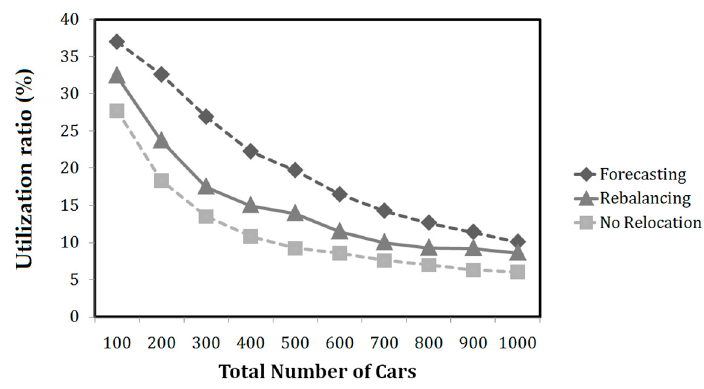
Figure 11. The impact of the number of cars on the utilization.